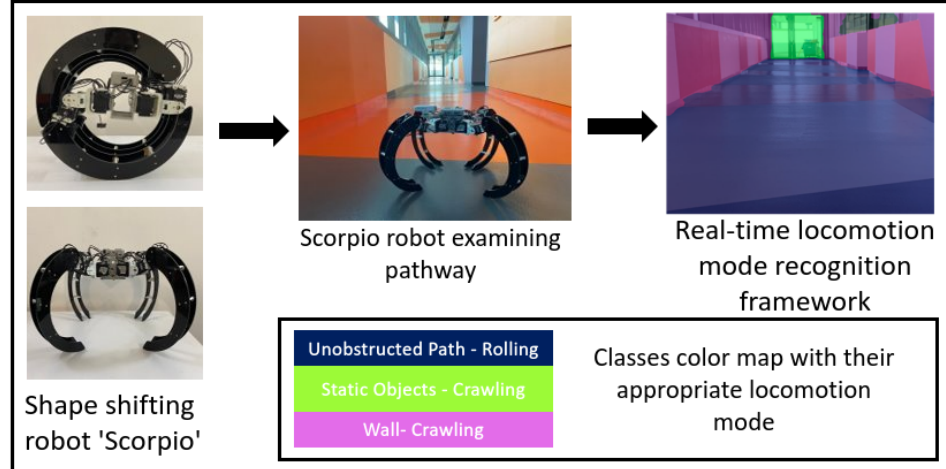
Figure 1. Overview diagram of proposed